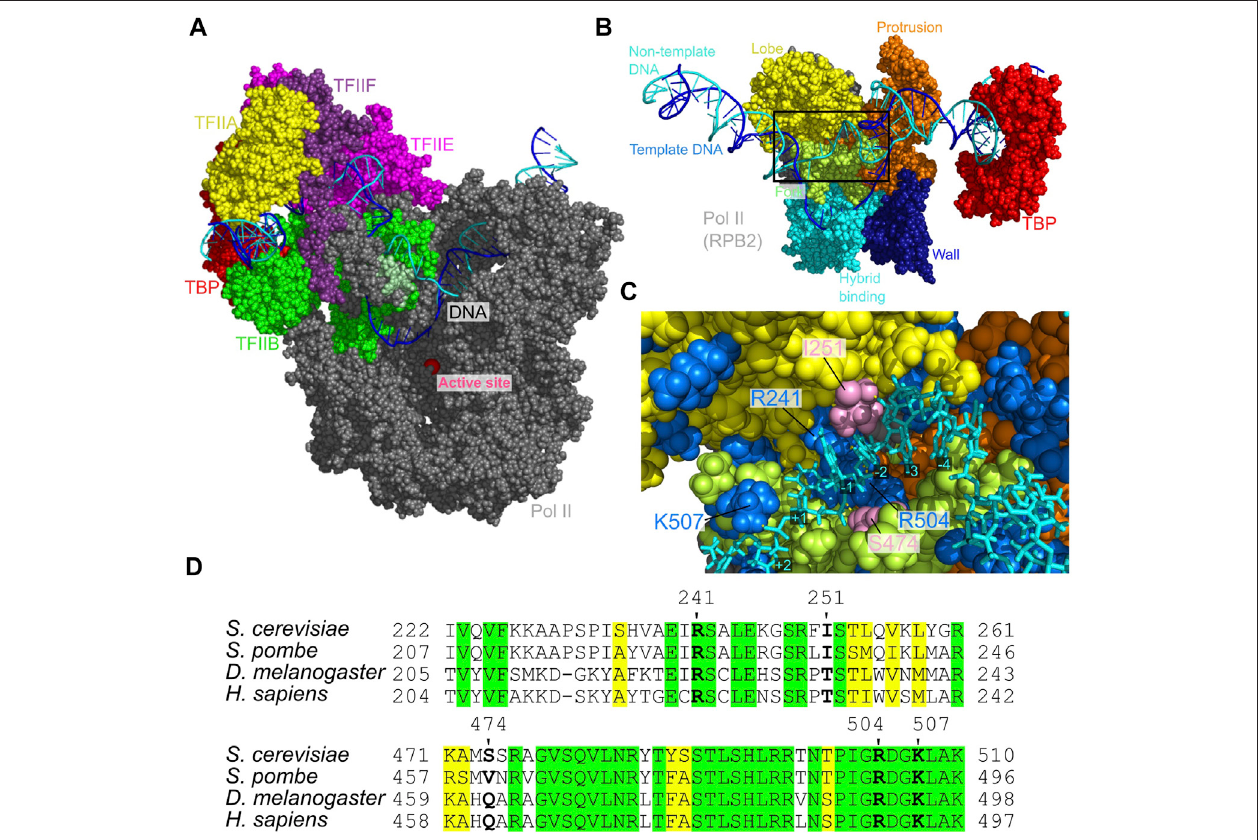
FIGURE 6 | The open DNA in the ITC state of PIC. (A) The atomic structure model for the ITC state. Some proteins are not displayed to make DNA visible. (B) The atomicstructure modelfrom theback sideof (A) ,whichfocusesthenon-templateDNAstrand path. (C) Theclose-upviewoftheRpb2andnon-templateDNAstrand in the squared areain (B) .Blue,positivelycharged residues; pink,I251 and S474that formhydrogen bondstoDNA; yellow dashed lines,hydrogen bonds between bases ofthe non-template DNAstrand and aminoacids. (D) Multiplesequence alignment oftheresidues around thoseshown in (C) . Green, invariant;